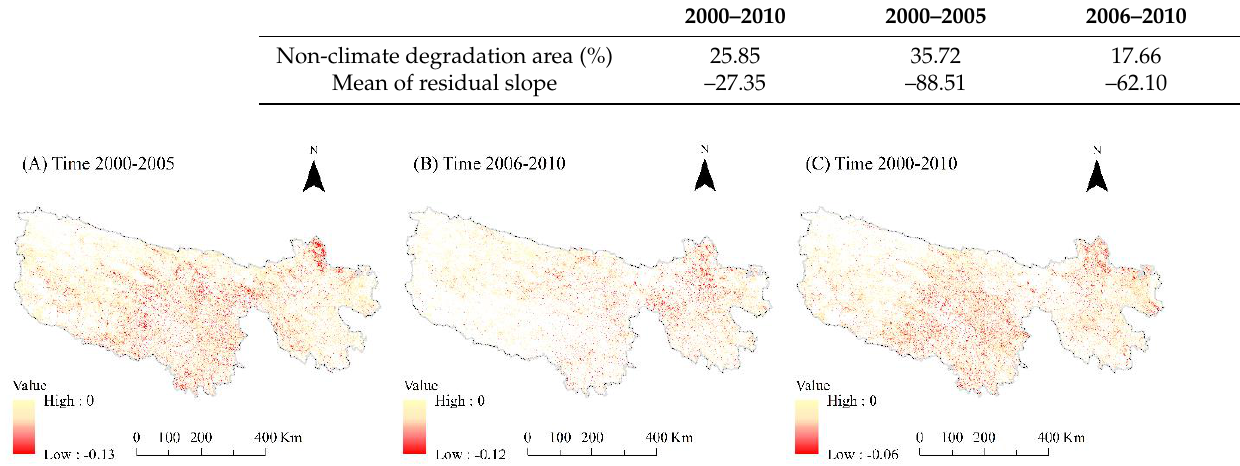
Figure 4. Grassland degradation trend due to human activities ( A ) residual NDVI from 2000 to 2005; ( B ) residual NDVI from 2006 to 2010; ( C ) residual NDVI from 2000 to 2010. (spatial reference: Albers conical equal area; datum: D WGS 1984). Table 4. Proportion of area showing non-climate degradation (units %) and the trend of the residual mean value.